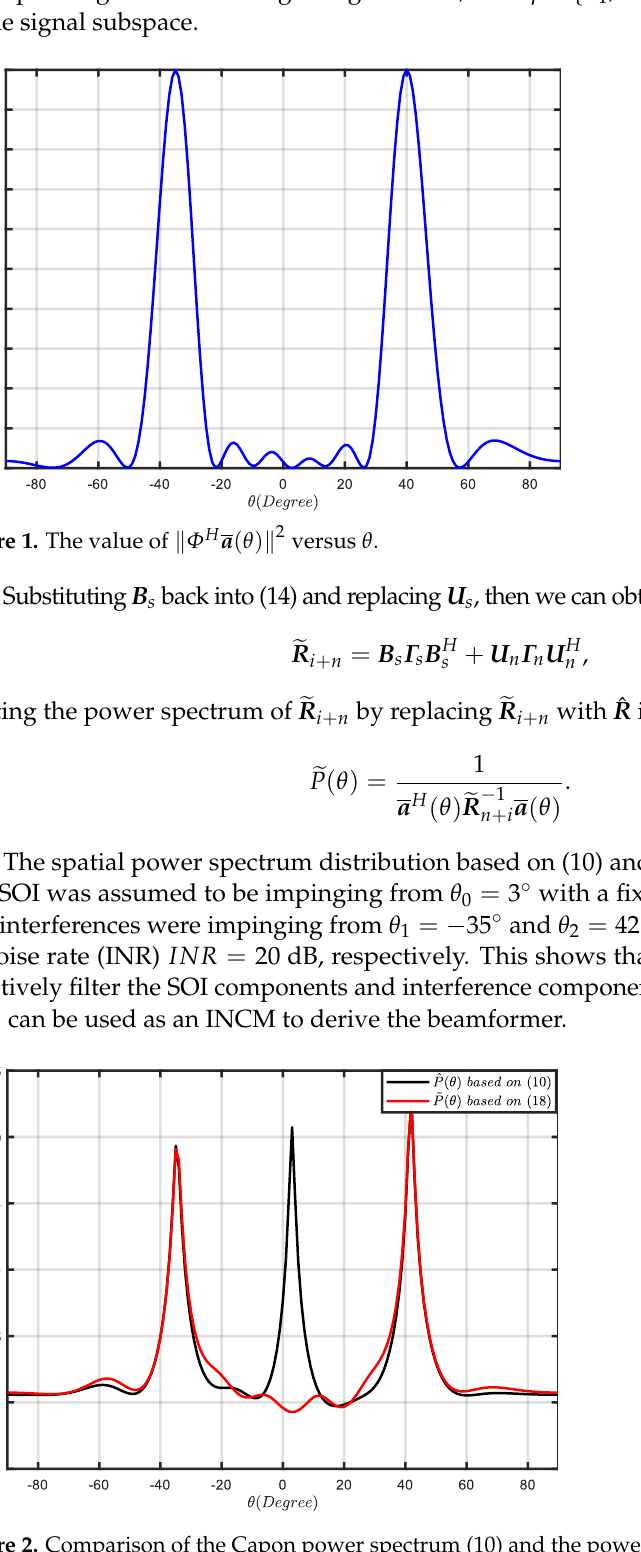
Figure 2. Comparison of the Capon power spectrum (10) and the power spectrum based on (18) with 𝑆𝑁𝑅 = 30 dB , 𝐼𝑁𝑅 = 20 dB , and 𝐾 = 100 .